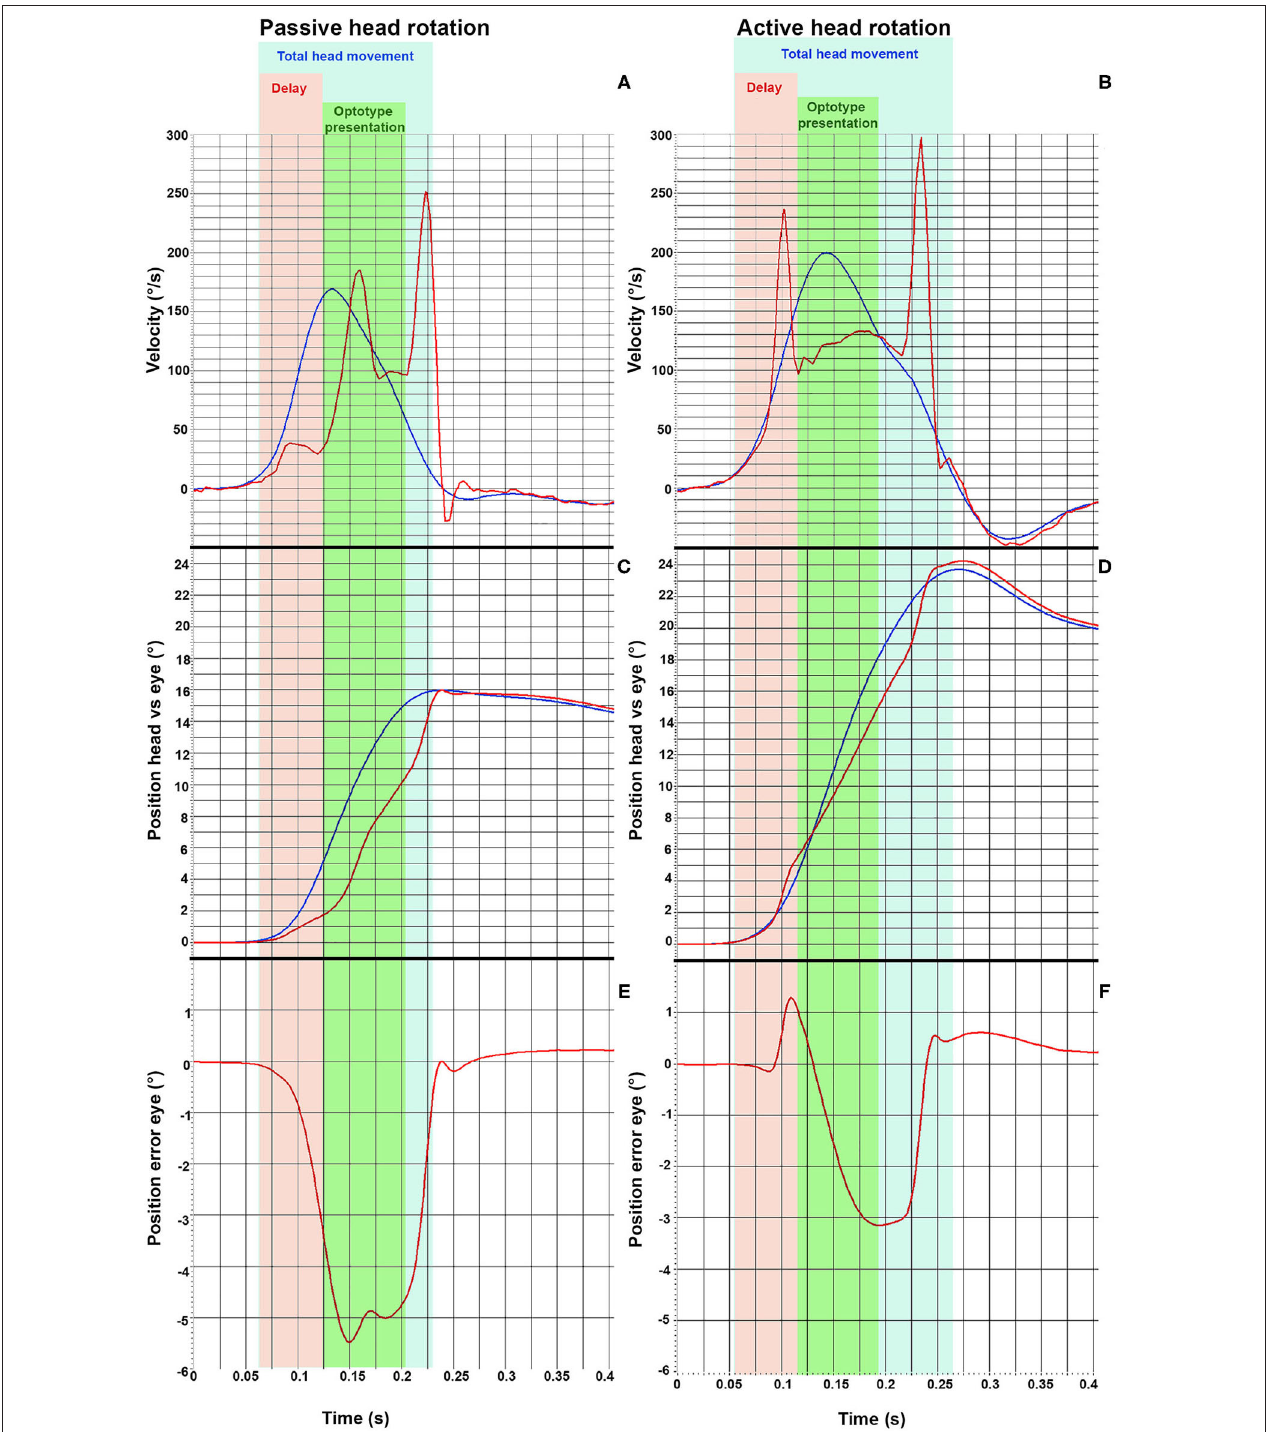
FIGURE 2 | vHIT traces from one representative subject during a passive head impulse (A,C,E) and during an active head impulse (B,D,F) toward the lesioned side (ipsilesional). The head velocity (blue line) and the eye velocity (red line) during the head thrust are displayed in (A,B) . The angular position of the head and of the eyes are displayed in (C,D). Finally, the error between the angular position of eyes with respect to the head position are displayed in (E,F) , where a negative value indicates that the eye movement lags behind the head movement. The different time frames analyzed are presented as different colors. The light blue area represents the total head movement. The orange field demarks the delay (62ms) and the green area demarks the optotype presentation, during which the optotype to be identified is presented to the subject (80ms).